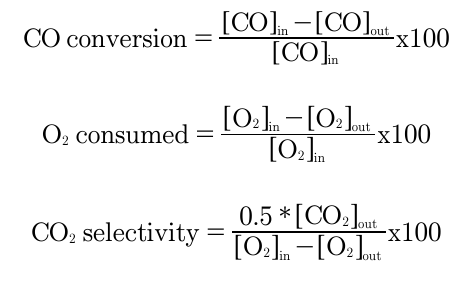
catalysts (1wt% Au and 99wt% TiO 2